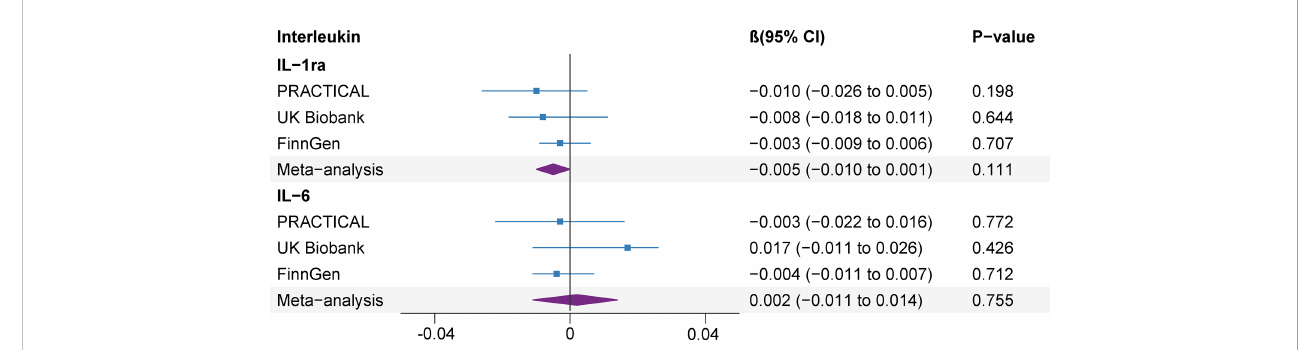
FIGURE 5 Association of genetic liability to prostate cancer with interleukin levels. CI, con fi dence interval; IL, interleukin; IL-1ra, IL-1 receptor